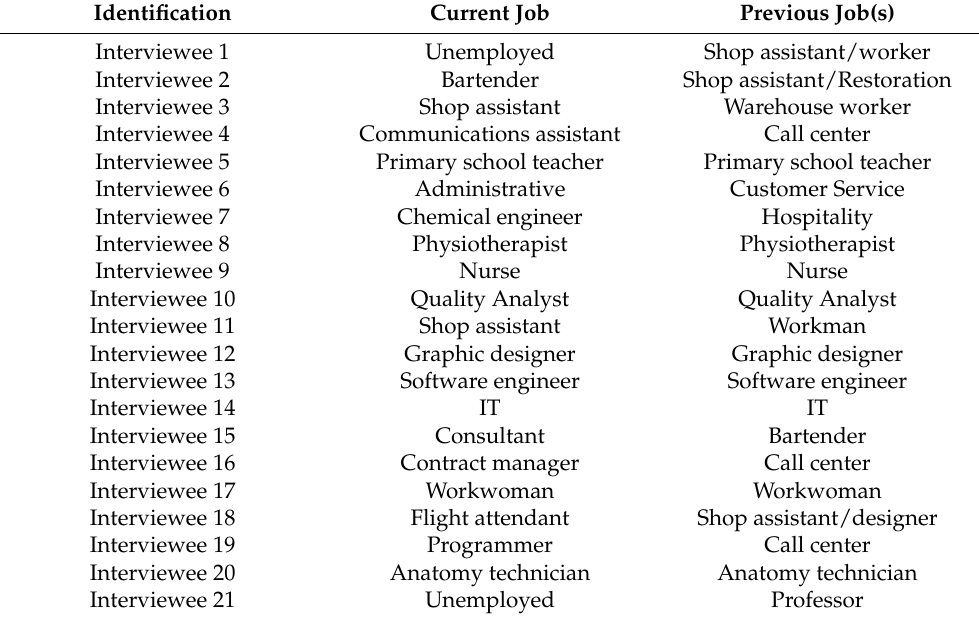
Table 2. Interviewees labor data.